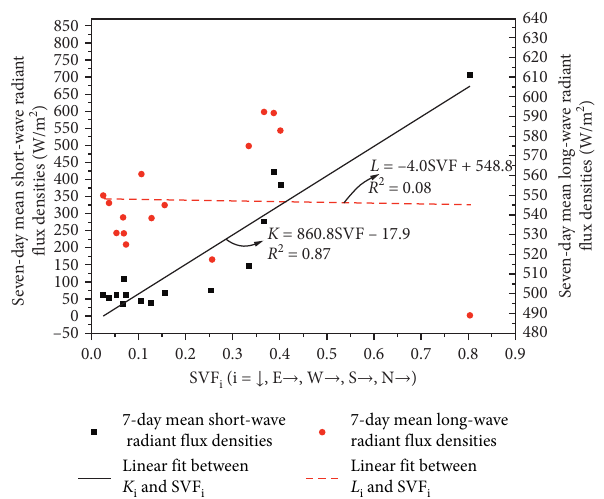
Figure 13: Linear fitting between seven-day mean short- or long- wave radiant flux densities and directional SVF i .